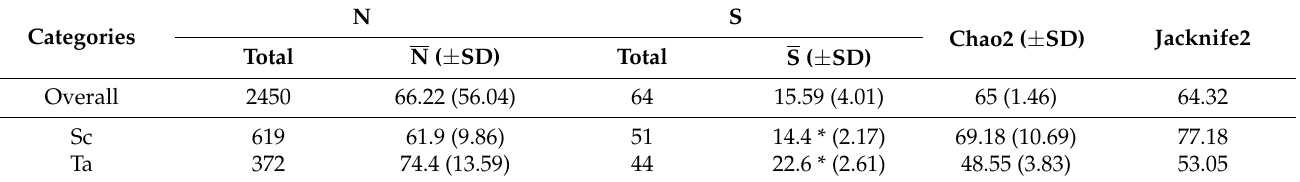
Total S, Total N, Chao2, and Jacknife2 were higher in the Sc habitat than in the Ta habitat (Table 3). (S was found statistically higher in Ta (S Ta = 22.6 ± 2.61) than in Sc (S Sc = 14.4 ± 2.17) (t = 5.06, df = 6.88, p -value = 0.00054). Species richness estimators and number of observations for the overall study are also presented in Table 3. Table 3. Comparison of species richness estimators (S, Chao2, Jacknife2) and number of observations (N) of birds between the overall study site and the Sc and the Ta habitats. For habitat labels, cf. Table 1. SD stands for Standard Deviation. An asterisk represents a statistically significant ( p -value < 0.05) difference between the two